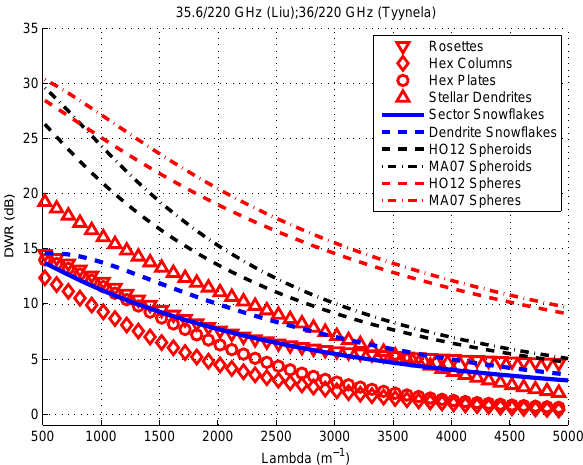
Figure 13. Dual-wavelength reflectivity ratio, DWR, as function of Fig.13. Dualwavelengthreflectivity(DWR)ratio asfunction of PSDslope coefficient (cid:3) forthe K a –220 GHz PSD slope coefficient 3 for the K a –220GHz frequency pair for dif- frequency pair for different crystal habits. ferent crystal